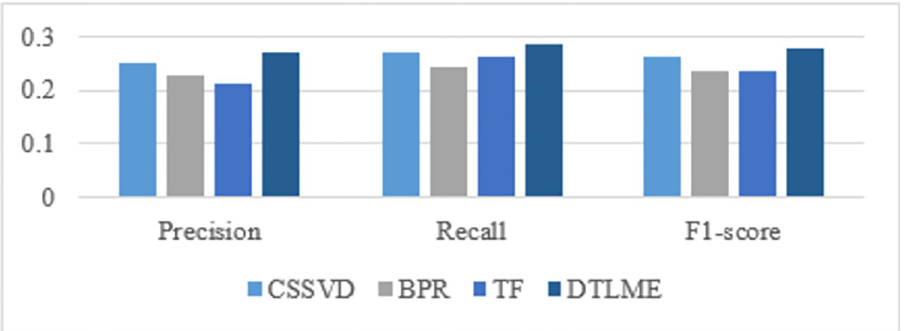
Fig 14. Comparative analysis of DTLME model with CSSVD, BPR and TF baseline RSs.